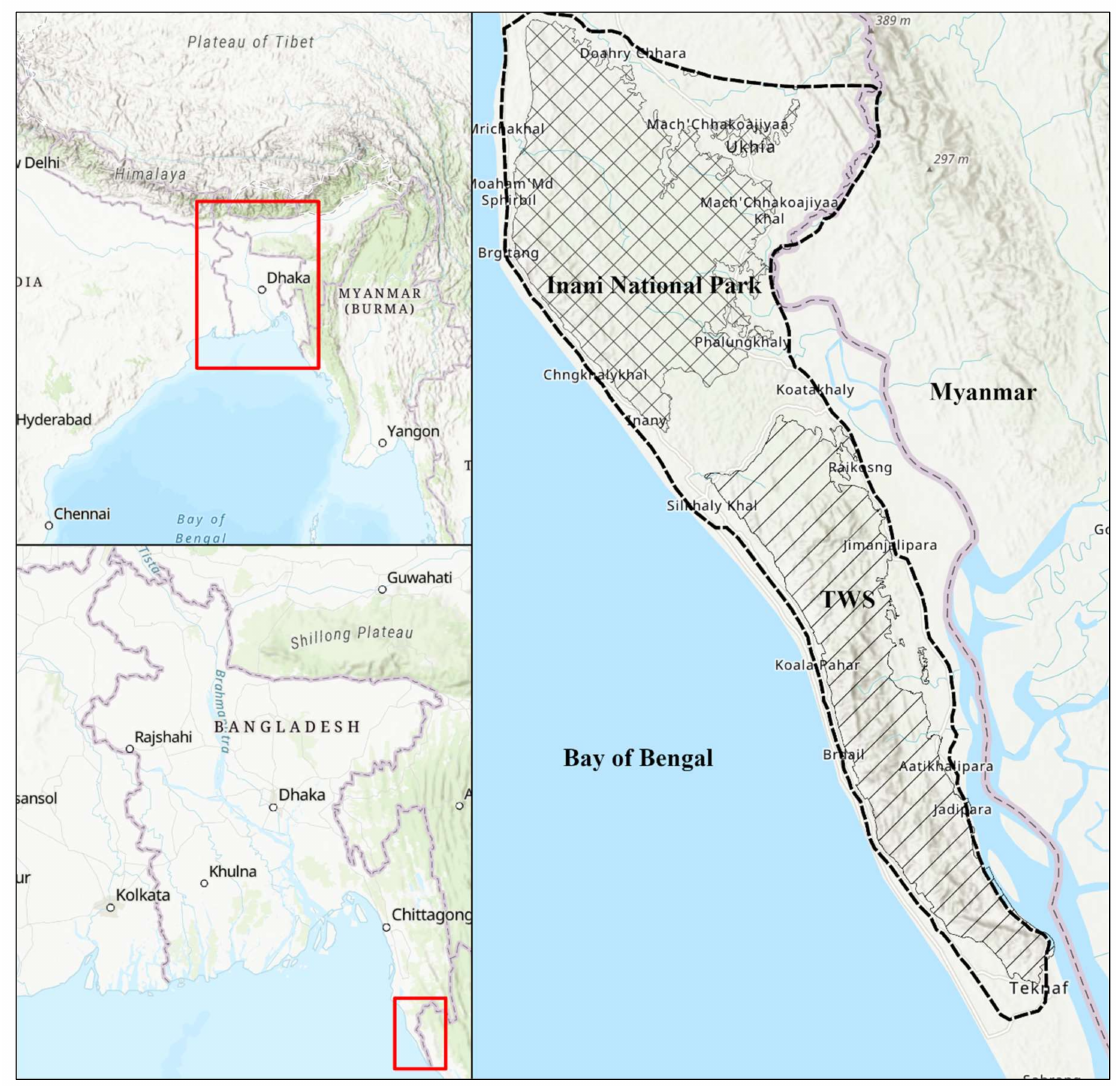
Figure 1. The study area (Cox’s Bazar–Teknaf peninsula) is situated in the southeast corner of Bangladesh. The study area consists of Teknaf Wildlife Sanctuary (TWS, shown as a simple hatch line on the map) and Inani National Park (INP, shown as a crosshatch line on the